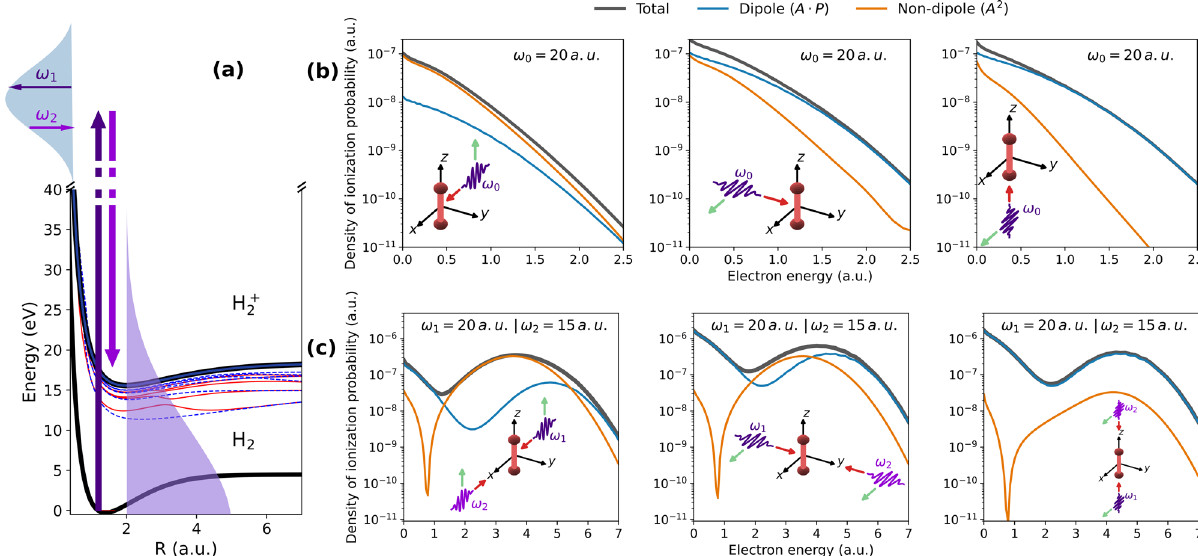
Fig. 1 Ionization accompanying stimulated Compton scattering. a Sketch of the stimulated Compton scattering (SCS) process from H 2 for the case of a single pulse. The thick vertical arrows indicate the absorption and emission of photons of frequency ω 1 and ω 2 , respectively. R is the internuclear distance. The two-shaded areas, blue and purple, show the effective bandwidths after the absorption and the emission of the ω 1 and ω 2 photons. b Ionization probabilities for the single-pulse case ( ω = 20 a.u.). c Idem for the case of two counter-propagating pulses ( ω 1 = 20 a.u. and ω 2 = 15 a.u.). Thick black line: total ionization probability. Blue line: dipole A ⋅ P contribution. Orange line: non-dipole A 2 contribution. In both b and c the pulse duration is 200 attoseconds and the peak intensity 10 18 W/cm 2 . Green arrows: pulse polarization direction. Red arrows: pulse incidence direction. Dark orange spheres nuclei. All directions referred to the cartesian x , y, and z axes. Purple wavefronts: attosecond pulse.